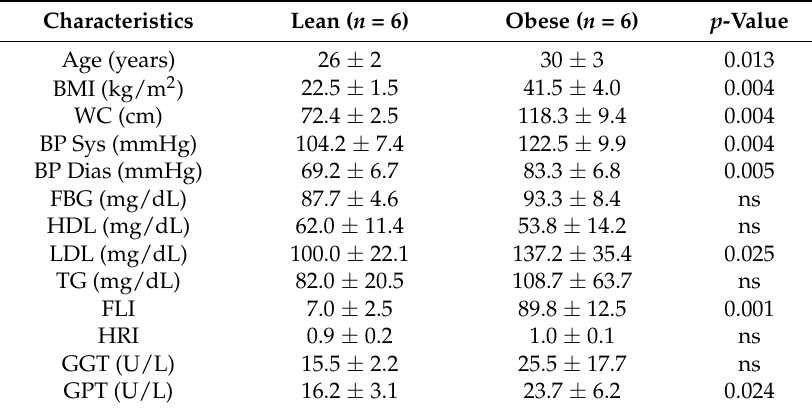
Table 1. Baseline characteristics of the study